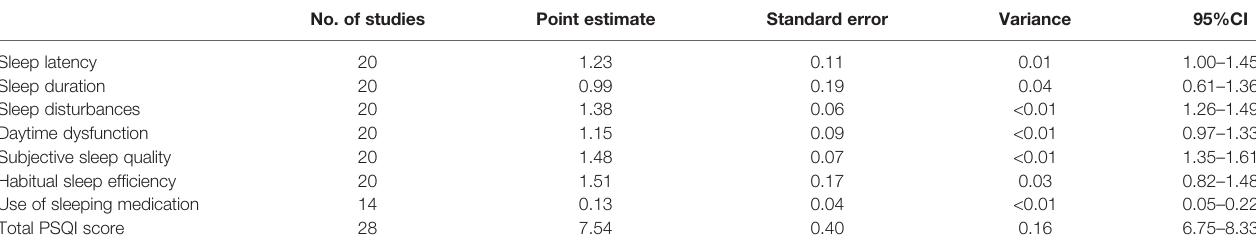
TABLE 2 | Pooled PSQI global and component